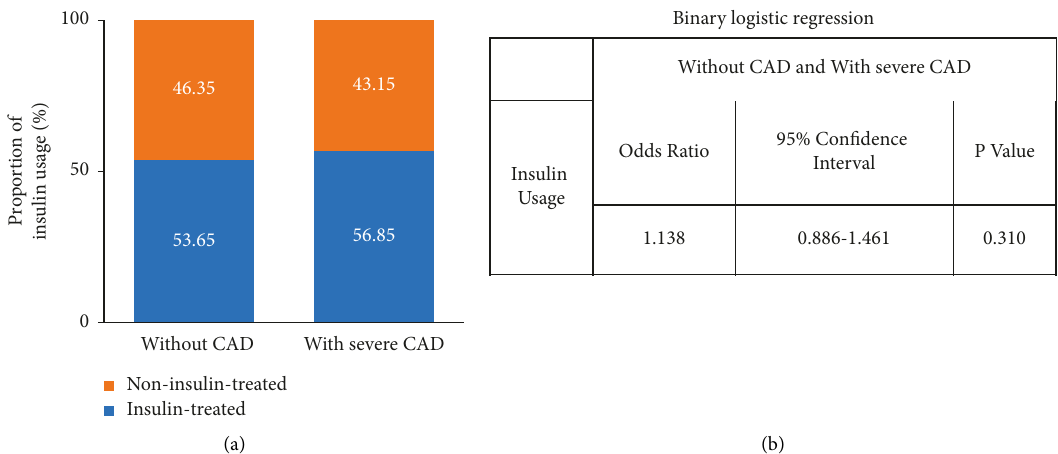
Figure 2: Analysis of insulin usage in patients with T2DM with severe CAD and without CAD. (a) Proportion. (b) Binary logistic regression. CAD, coronary artery disease.